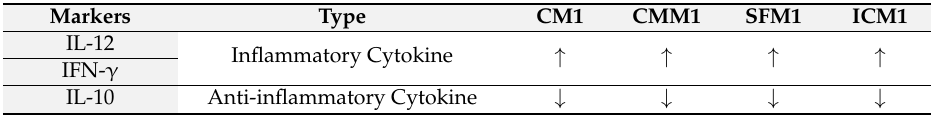
Table 4. DBMSC (CMDBMSC, SFDBMSC, and ICDBMSC) effects on macrophage stimulatory effects on T cell proliferation and secretion of inflammatory and anti-inflammatory cytokines as compared to untreated T cells measured by ELISA. Increased ( ↑ ) and decreased ( ↓